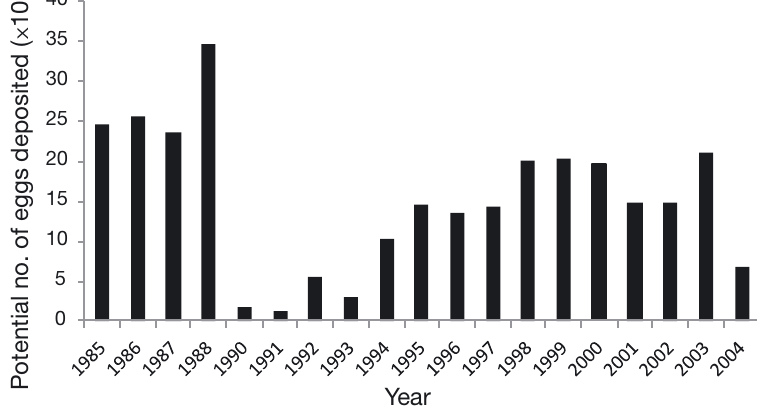
Fig. 6. Estimated potential sea trout Salmo trutta egg deposition, Tawnyard catchment,